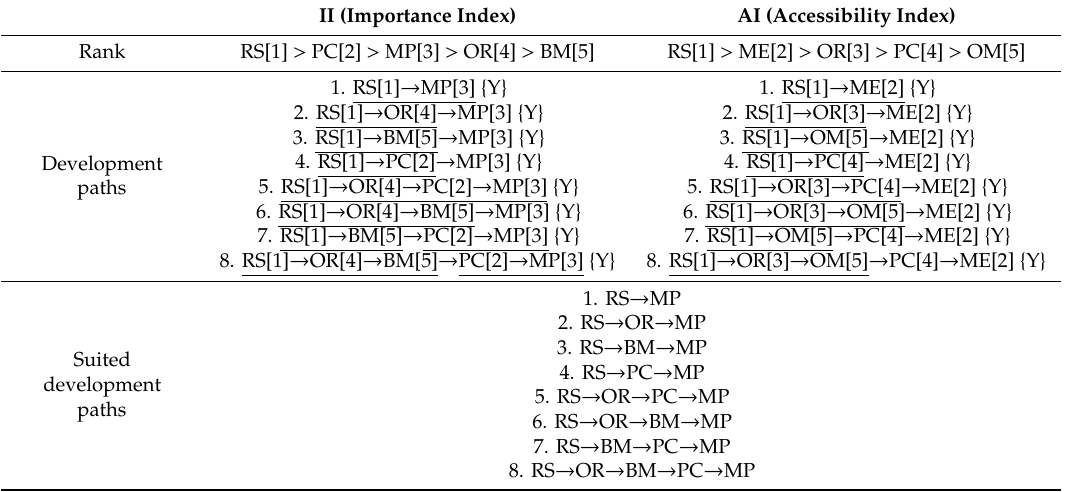
Table 17. The suited development paths for